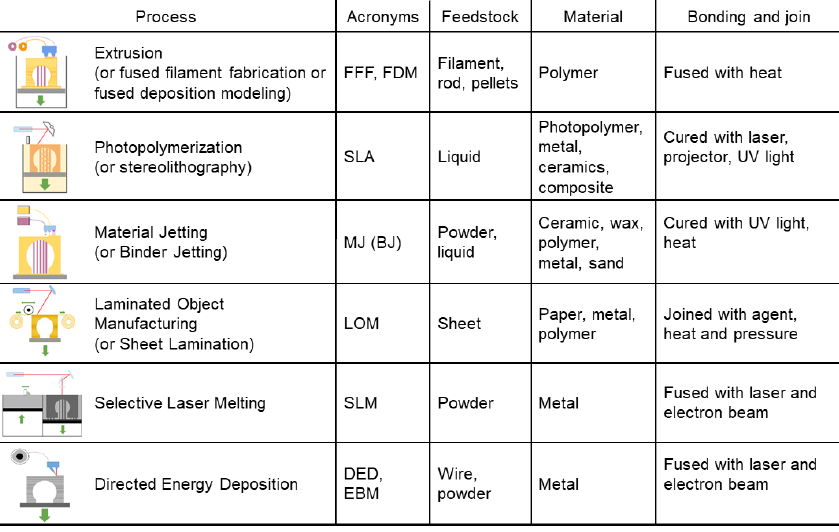
Figure 1. Overview scheme on additive manufacturing (AM) processes.